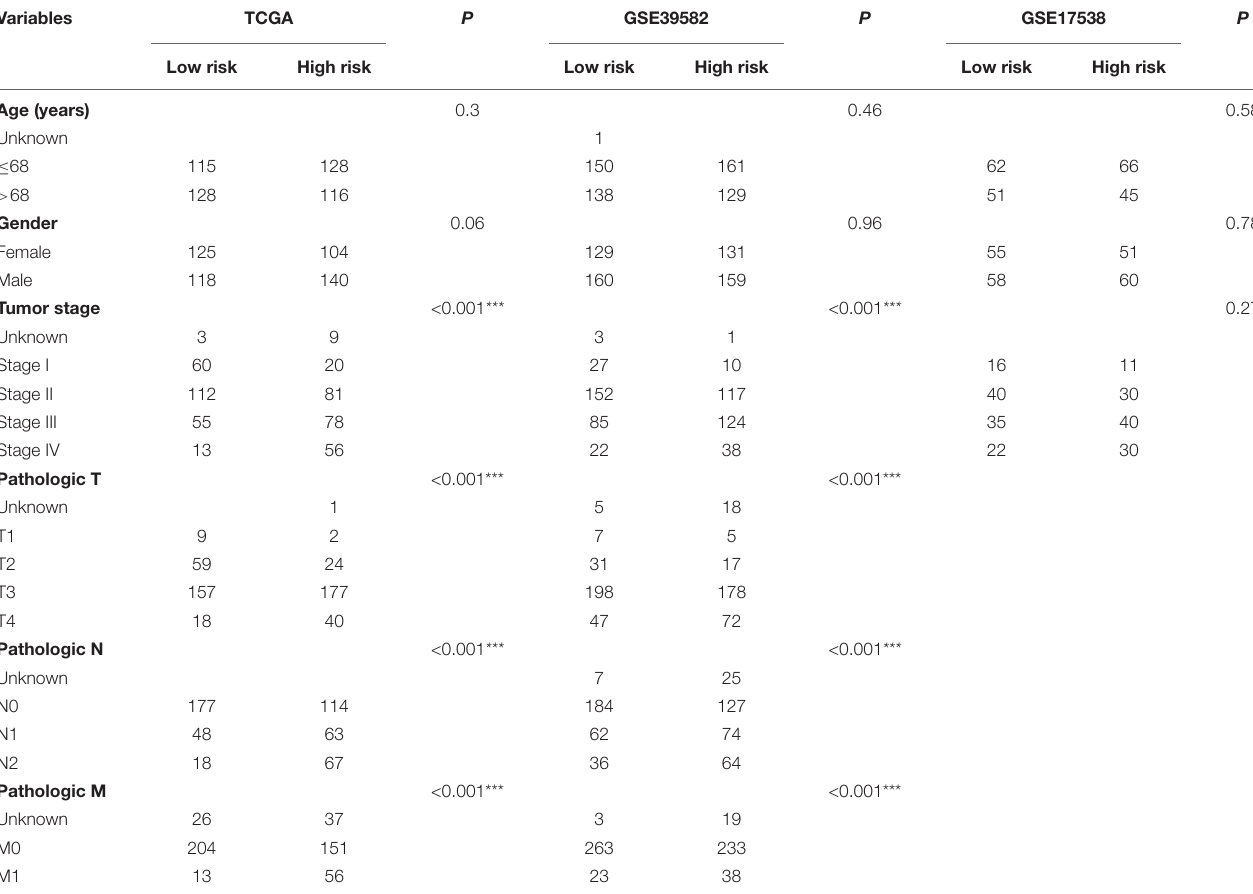
TABLE 3 | Association of the IRG signature with clinical characteristics in CRC